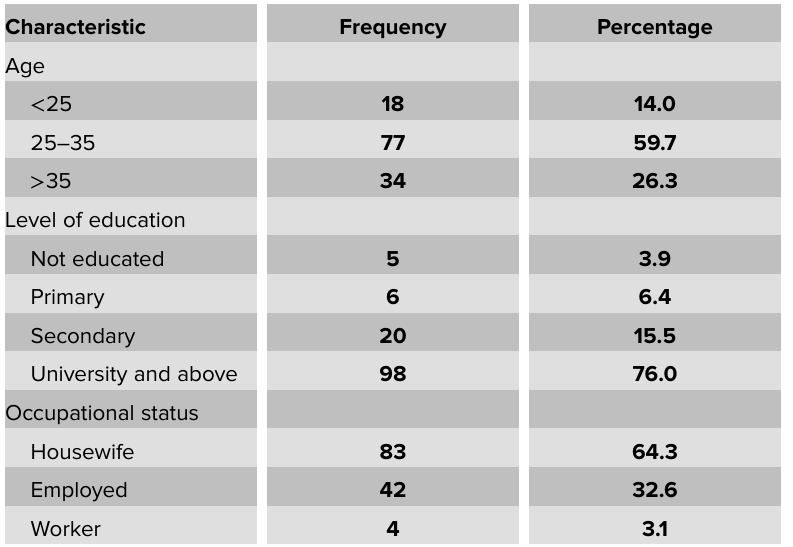
TABLE 1: Socio-demographic characteristics of mothers screened for PPD at the Saad Abueleella and Dream International Hospitals; n =